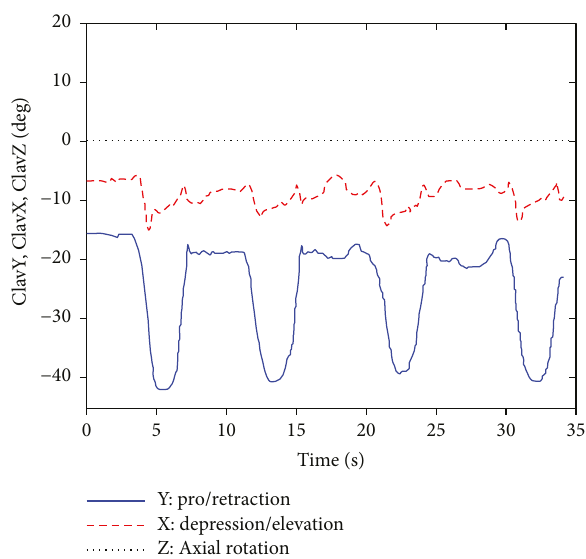
Figure 7: The posture of the clavicle that is adopted to be input parameters (ABD).